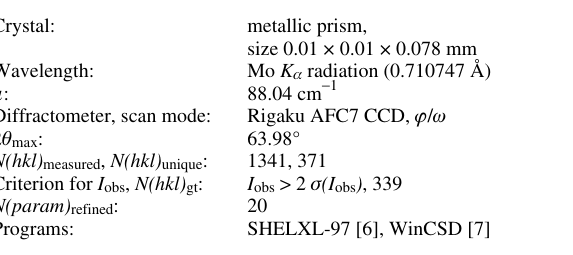
Table 3. Data collection and handling.